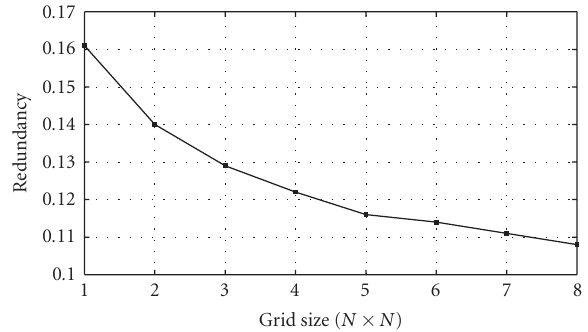
Figure 2: Resulting overhead by varying the gridsize in the H.264/AVC